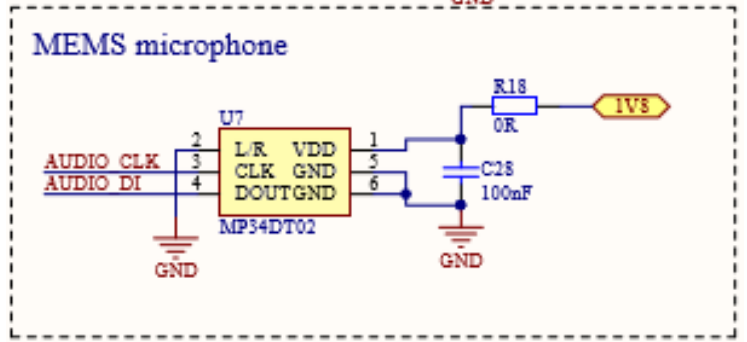
Figure 6. MEMS microphone application.